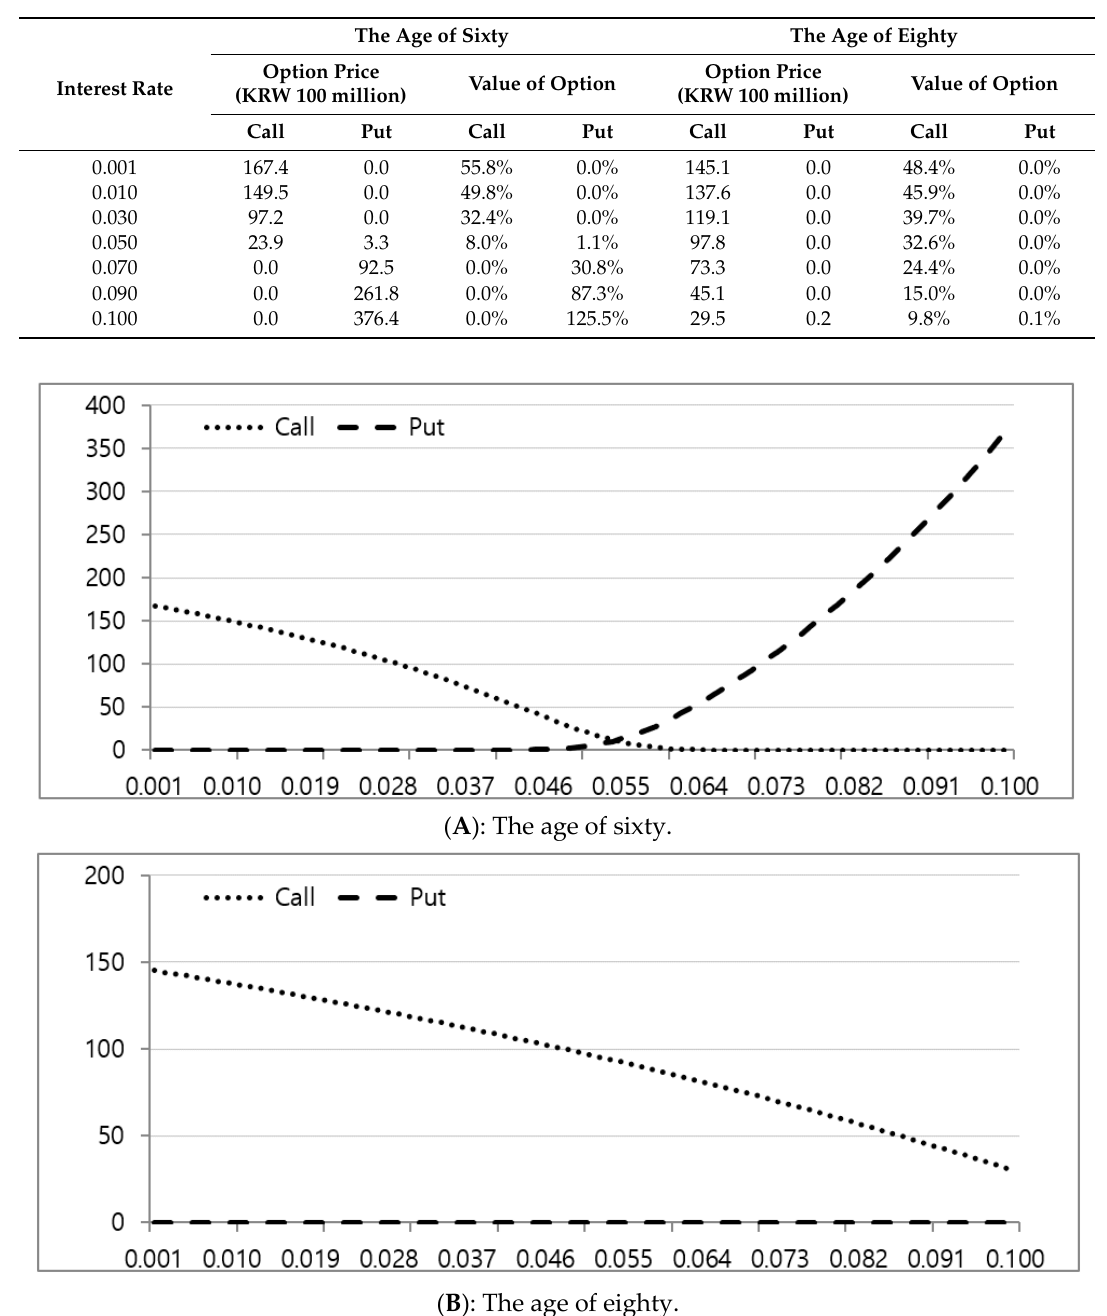
Figure 3. Exercise price sensitivity analysis. This figure presents the estimated total option value by age group.